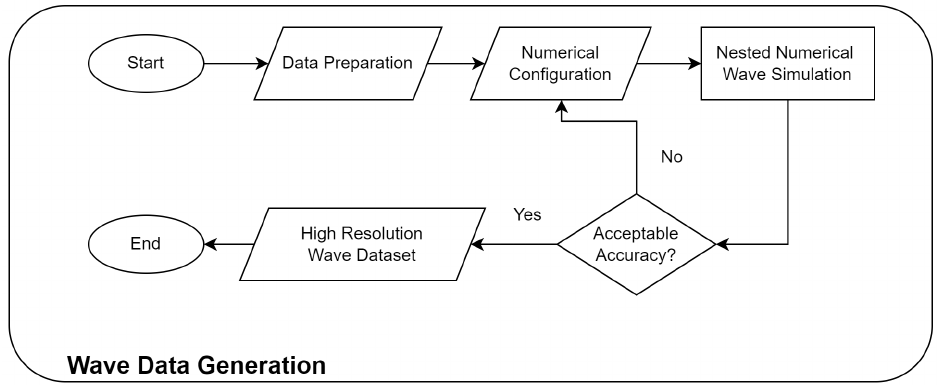
Figure 5. Flowchart of wave data generation. The wave dataset is obtained by performing continuous wave simulation using phase-averaged wave model